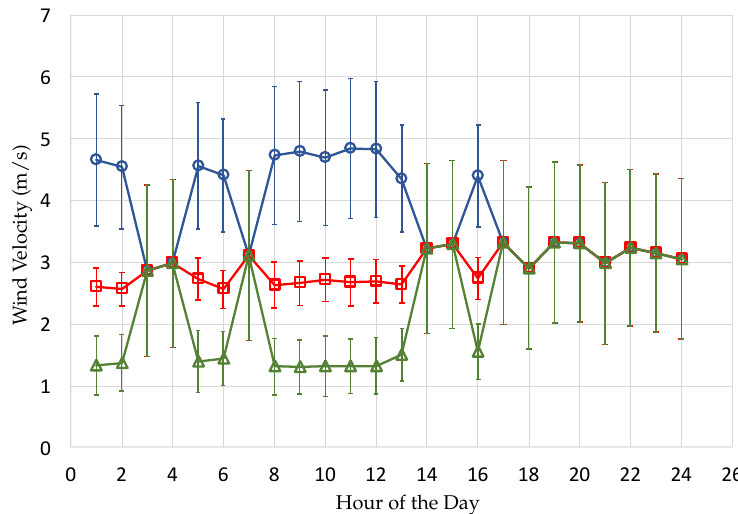
Figure 5. Velocity profile for the three components of the MONA for the wind producer [44]. Component 1 (– ◦ – blue), Component 2 (– (cid:3) – red), and Component 3 (– (cid:52) – green).